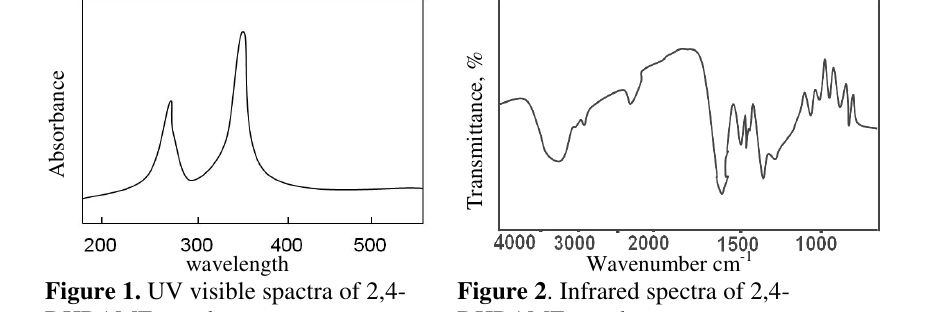
Figure 1. UV visible spactra of 2,4- DHBAMF copolymer.